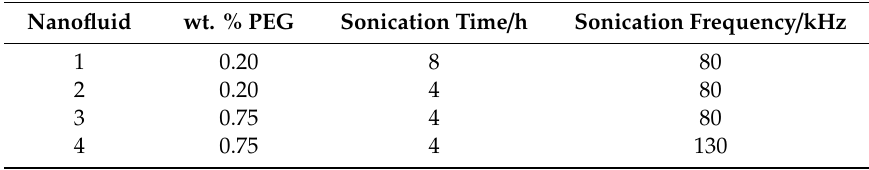
Table 1. Conditions used for preparing